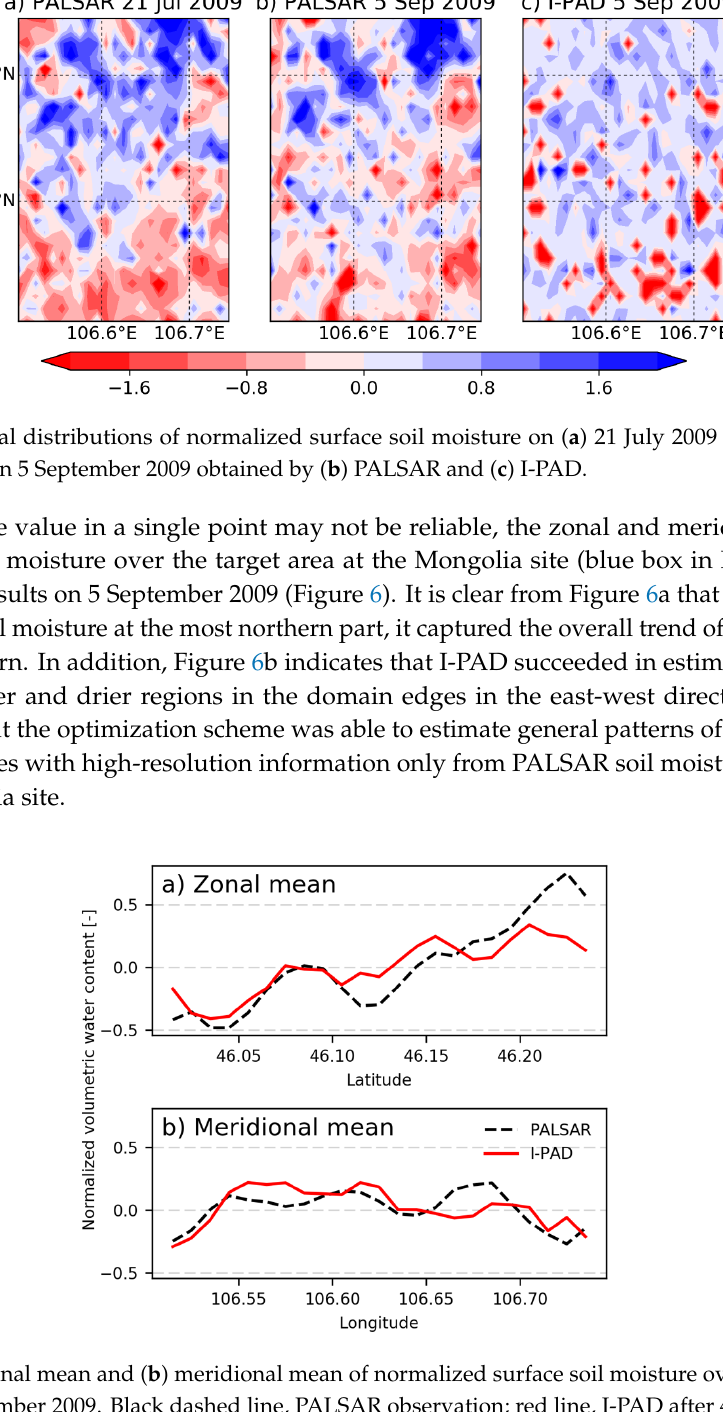
Figure 6. ( a ) Zonal mean and ( b ) meridional mean of normalized surface soil moisture over the study area on 5 September 2009. Black dashed line, PALSAR observation; red line, I-PAD after 40 days run.